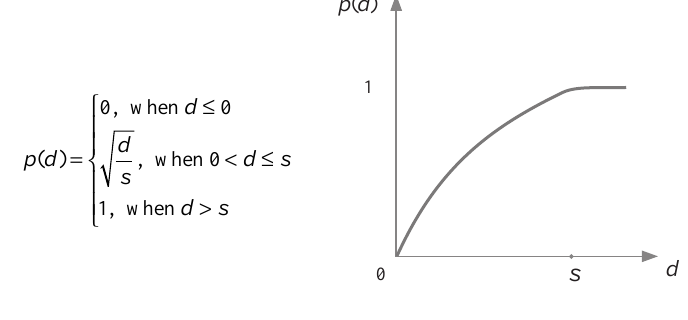
Fig. 8. C-shape preference function and its graph